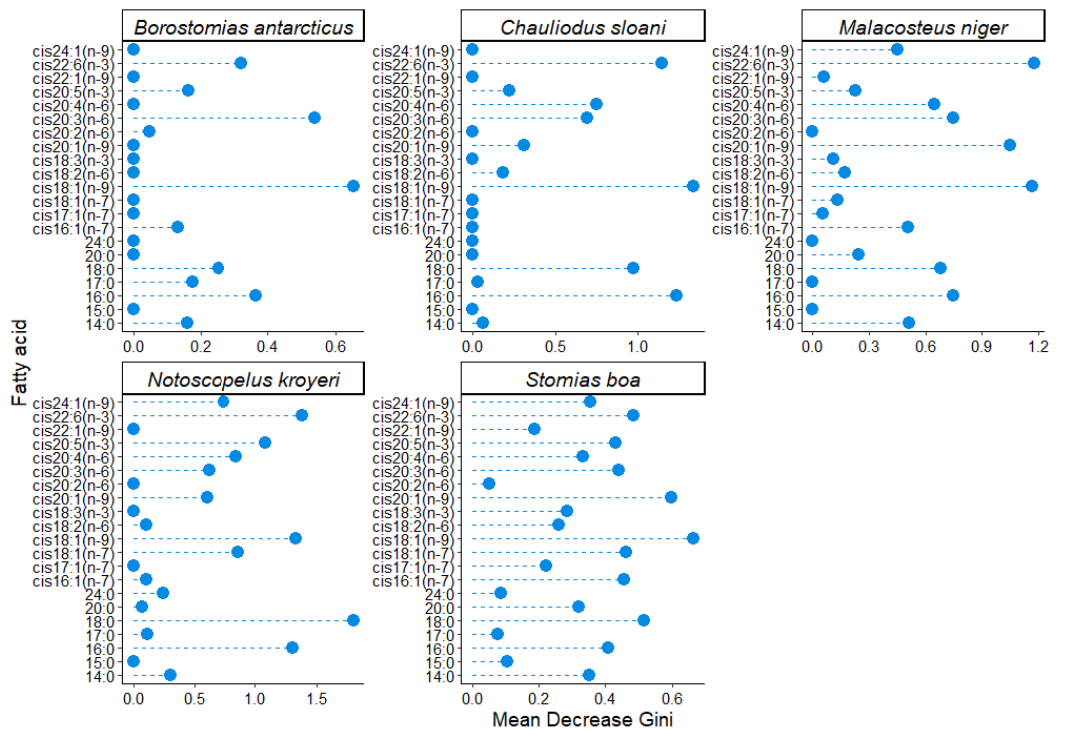
Figure 5. Gini coefficient values obtained using a machine learning (RandomForest) algorithm for individual fatty acids in the fraction of structural phospholipids in muscle tissues of mesopelagic fishes ( Notoscopelus kroyeri , Symbolophorus veranyi , Chauliodus sloani , Stomias boa , Malacosteus niger , and Borostomias antarcticus ) across the depth gradient in the Irminger Sea (North Atlantic). Having applied the canonical correspondence analysis (CCA), it was found that a rise in temperature and salinity entailed a reduction in the concentrations of FA compo- nents in muscle tissues, excluding the rise in the concentration of the 18:0 FA in Ch. sloani and B. antarcticus (from 0.04 to 0.14 and from 0.07 to 0.11 µg/mL, respectively) (Figure 6). A noteworthy distinctive feature of these 2 fish species was a rise in the content of the cis20:1(n-9) FA (from 0.00 to 0.02 µg/mL) in Ch. sloani and an increase in the concentration of the cis20:2(n-6) FA (from 0.00 to 0.01 µg/mL) in B. antarcticus in PL molecules under a comparatively higher temperature and salinity. The concentrations of individual FAs proved to increase depth-wise in all the studied fish species.